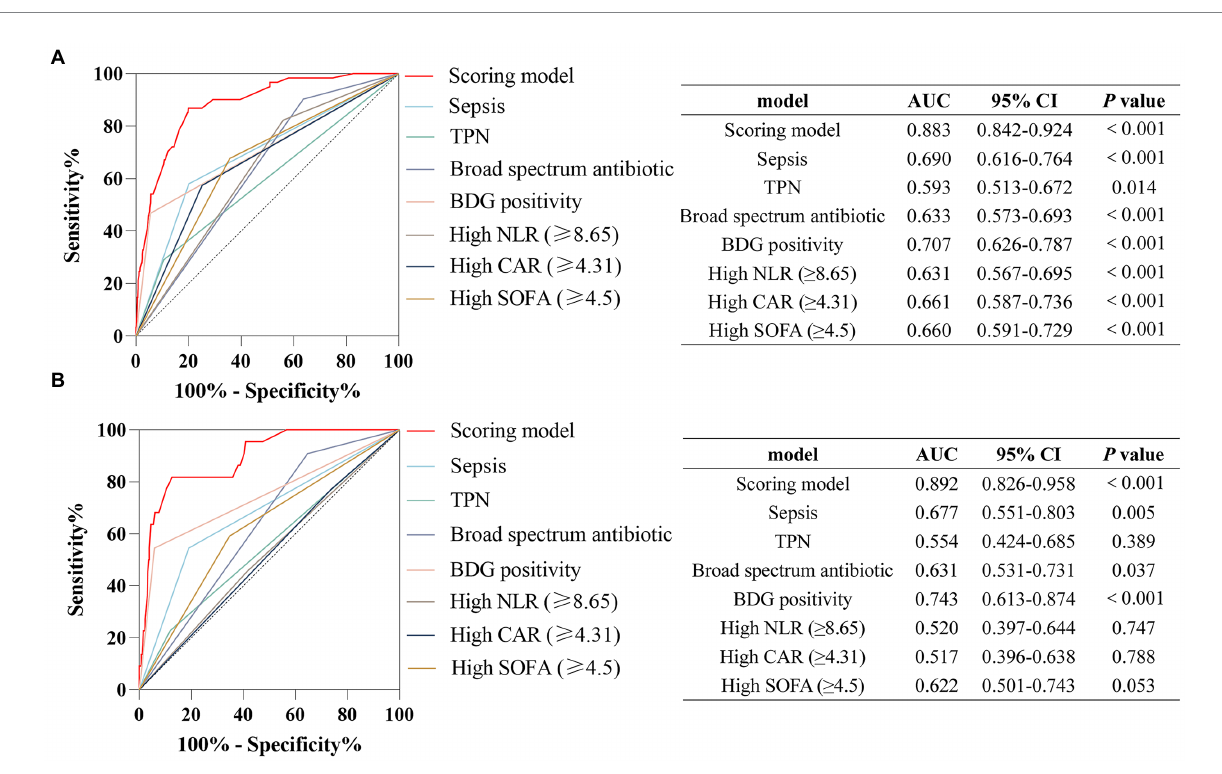
FIGURE 5 Receiver operating characteristic curves of the predictive model and single variables for the prediction of IC risk in (A) the development cohort, (B) the validation